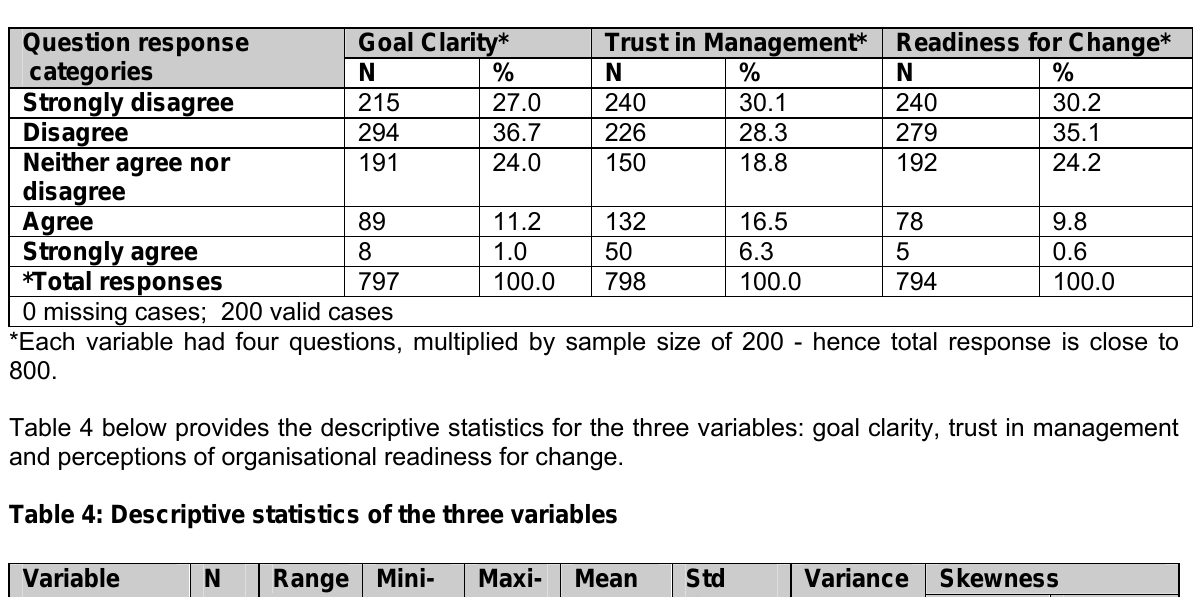
Table 3: Summation of all responses to the questions on the three variables